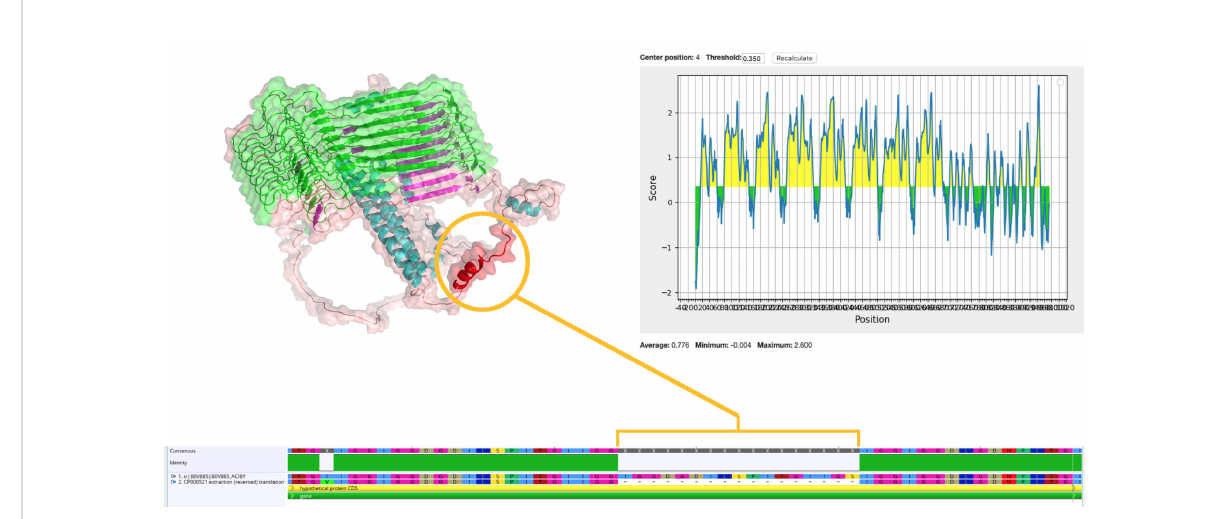
FIGURE 3 Predicted epitope regions and 3D structure of B0V885 protein. Circled red helix was a 17 – amino acid length region in the resistant strain, whereas it was not present in the sensitive